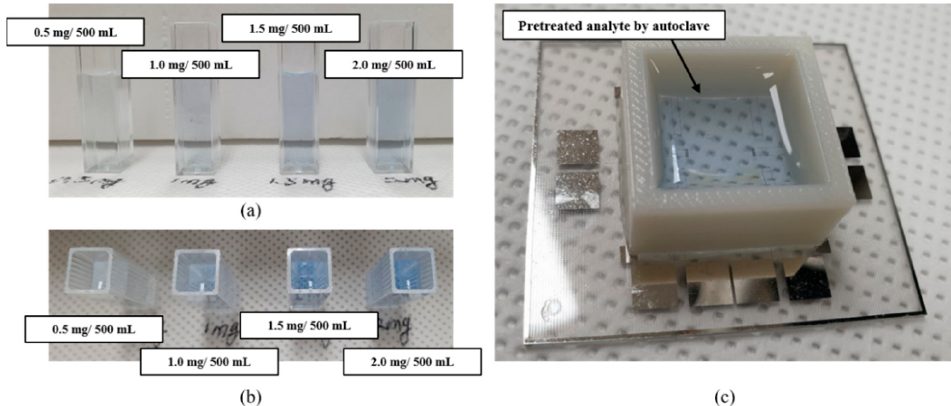
Figure 11. Autoclave-pretreated and blue-colored analytes with various TP concentrations: ( a ) cross view and ( b ) top view; ( c ) analyte transferred to the fabricated TP sensor for the blue-colored analyte absorbance measurement.